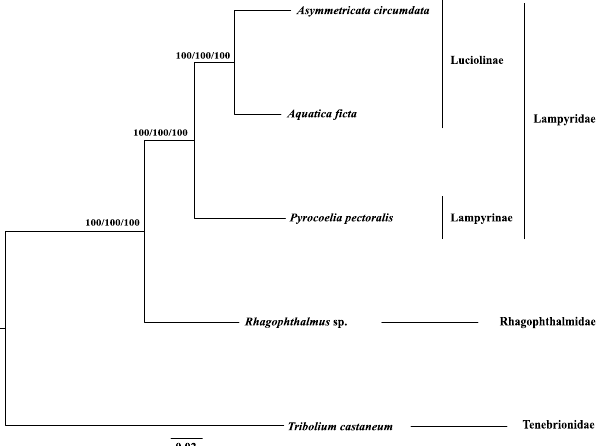
Figure 2. Phylogenetic relationships between Rhagophthalmidae and Lampyridae inferred from the concatenated 4325 nuclear gene markers with the third codon positions removed, Tribolium castaneum was chosen to be the outgroup. Numbers at each node are the ML bootstrap values/Bayesian posterior probabilities/ MP-EST bootstrap values, shown as